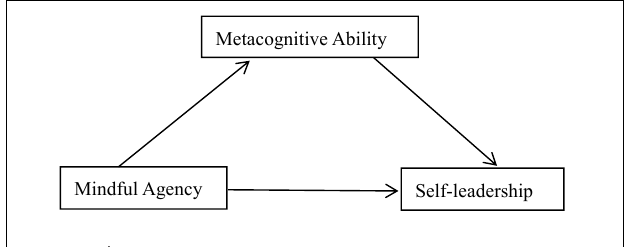
FIGURE 1 | Hypothesis